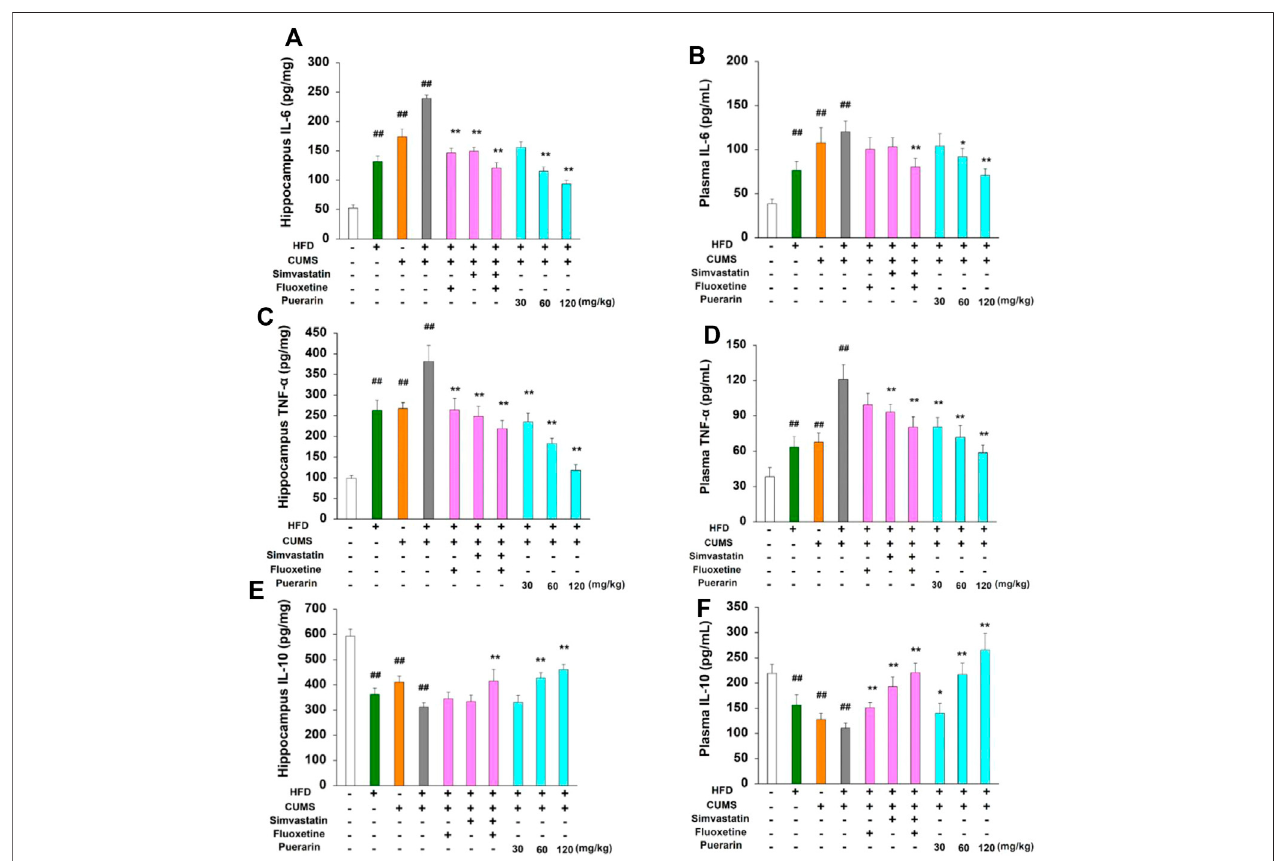
FIGURE3| EffectofpuerarinonproteinexpressionofIL-6,TNF- α ,andIL-10inhippocampaltissuesandplasma.Afterdrugtreatmentforconsecutive7 days(one time per day), plasma and hippocampal tissues were obtained. The protein levels of IL-6 (A, B) , TNF- α (C, D) , and IL-10 (E, F) in hippocampal tissues and plasma were detected by using commercial ELISA kits, respectively. The results of hippocampal tissues were corrected as picogram per milligram protein. Values are expressed as mean ± S.E.M ( n (cid:2) 8). ## p < 0.01 vs. the normal control group; * p < 0.05 and ** p < 0.01 vs. the HFD/CUMS group.